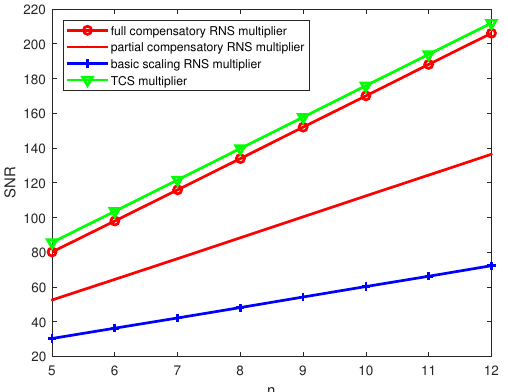
Figure 7. SNR of three kinds of